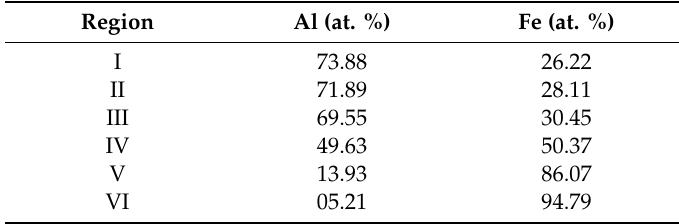
Table 2. The EDS analysis of aluminide layer under optimal